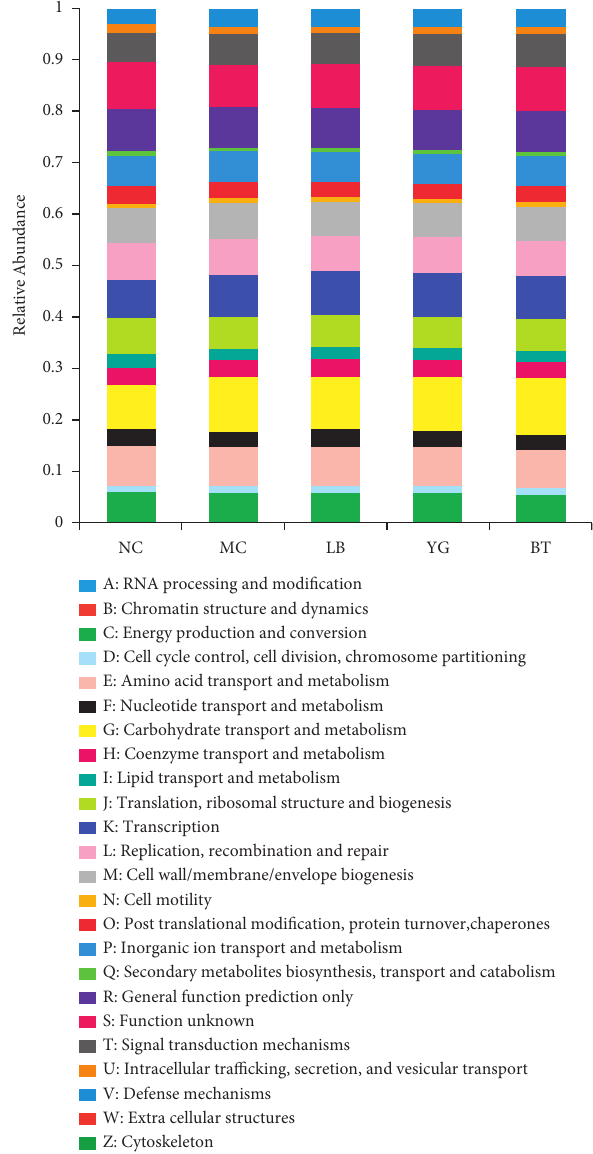
Figure 4: COG function classification analysis of different groups. The relative abundance was calculated using the average abun- dances via PICRUSt. NC, normal group; MC, model group; LB, Lacidophilin tablet group; YG, yogurt group; BT, bifid triple viable capsule